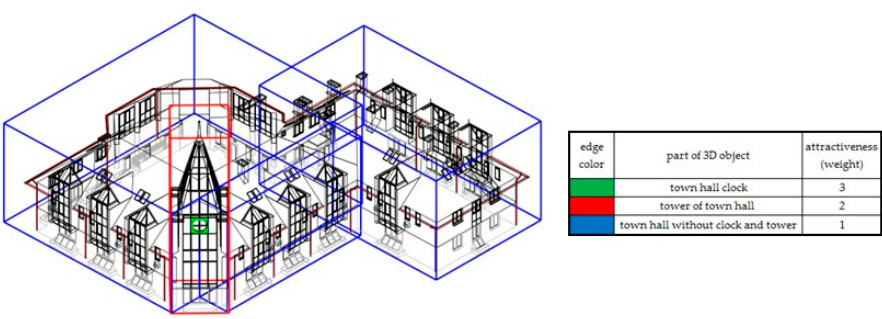
Figure 4. Designation of zones for the town hall with assigned attractiveness weight. Source: own work